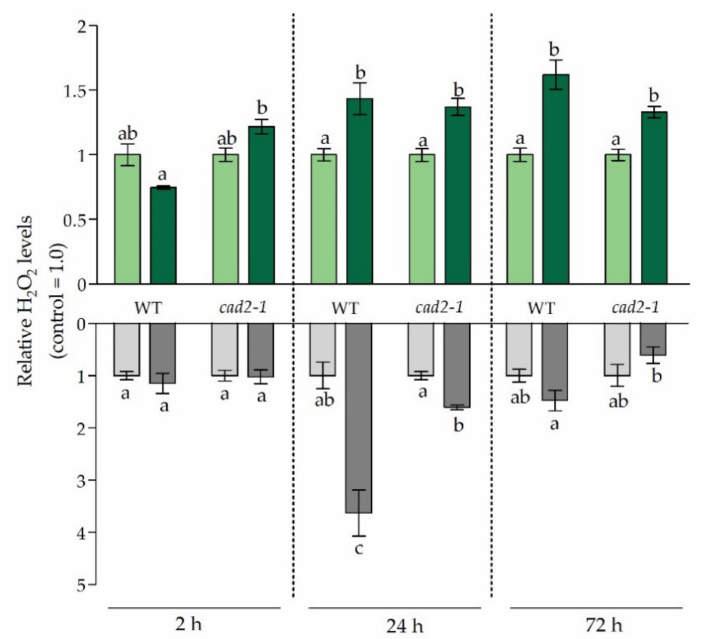
Figure 3. Relative hydrogen peroxide (H 2 O 2 ) levels in leaves (green bars) and roots (grey bars) of 3-week-old wild-type (WT) and cad2-1 mutant Arabidopsis thaliana plants grown under control conditions (0 µ M CdSO 4 , light bars) or exposed to 5 µ M CdSO 4 (dark bars) during 2 h, 24 h, and 72 h. Data are presented as the mean ± S.E. of at least three biological independent replicates relative to the control of the corresponding genotype set at 1.00. Significant differences (2-way ANOVA: p < 0.05) within each time point are indicated with different